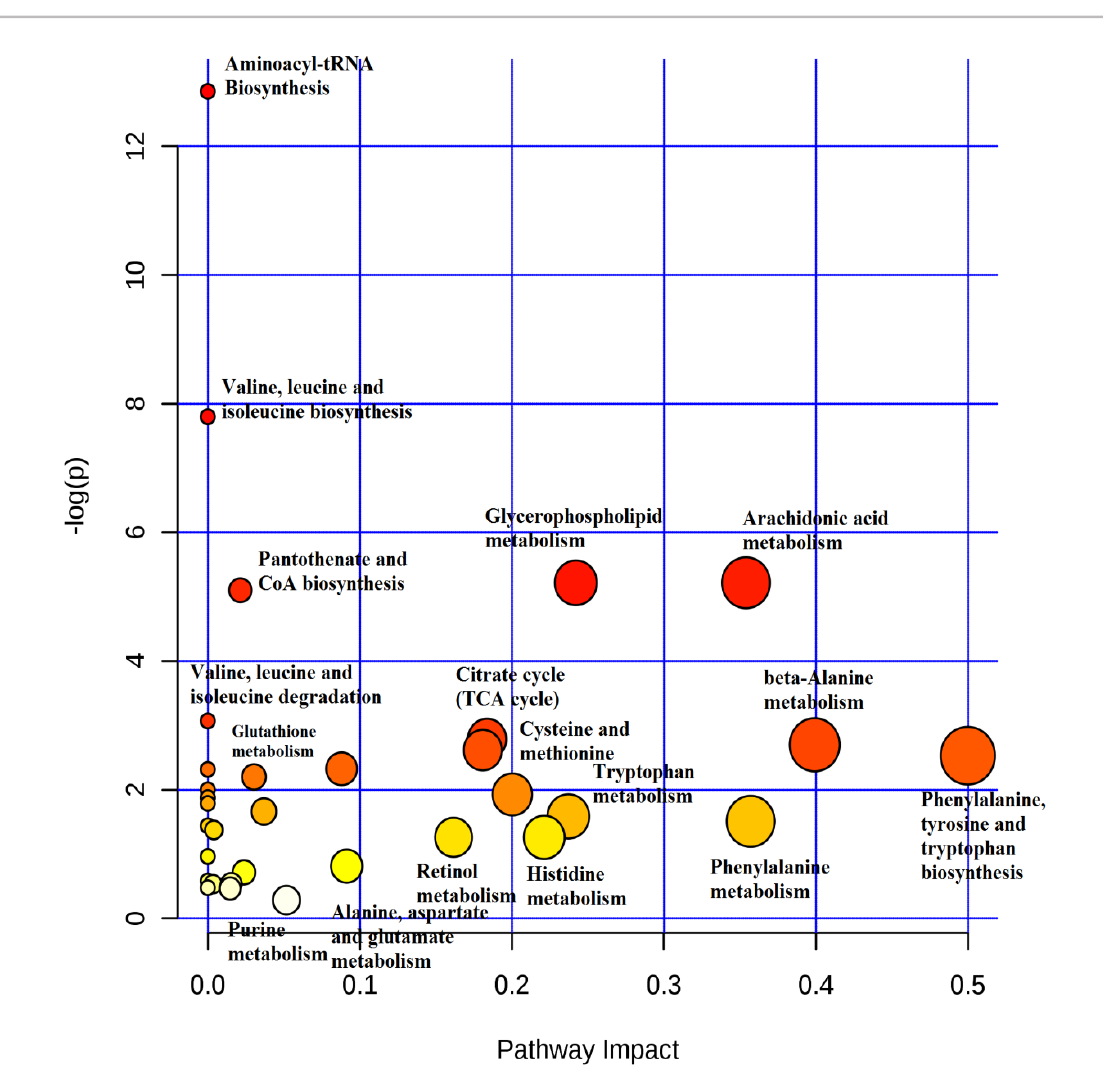
FIGURE 6 - Impact analysis for pathways created by MetaboAnalyst online: main pathways altered in the drug group vs the control